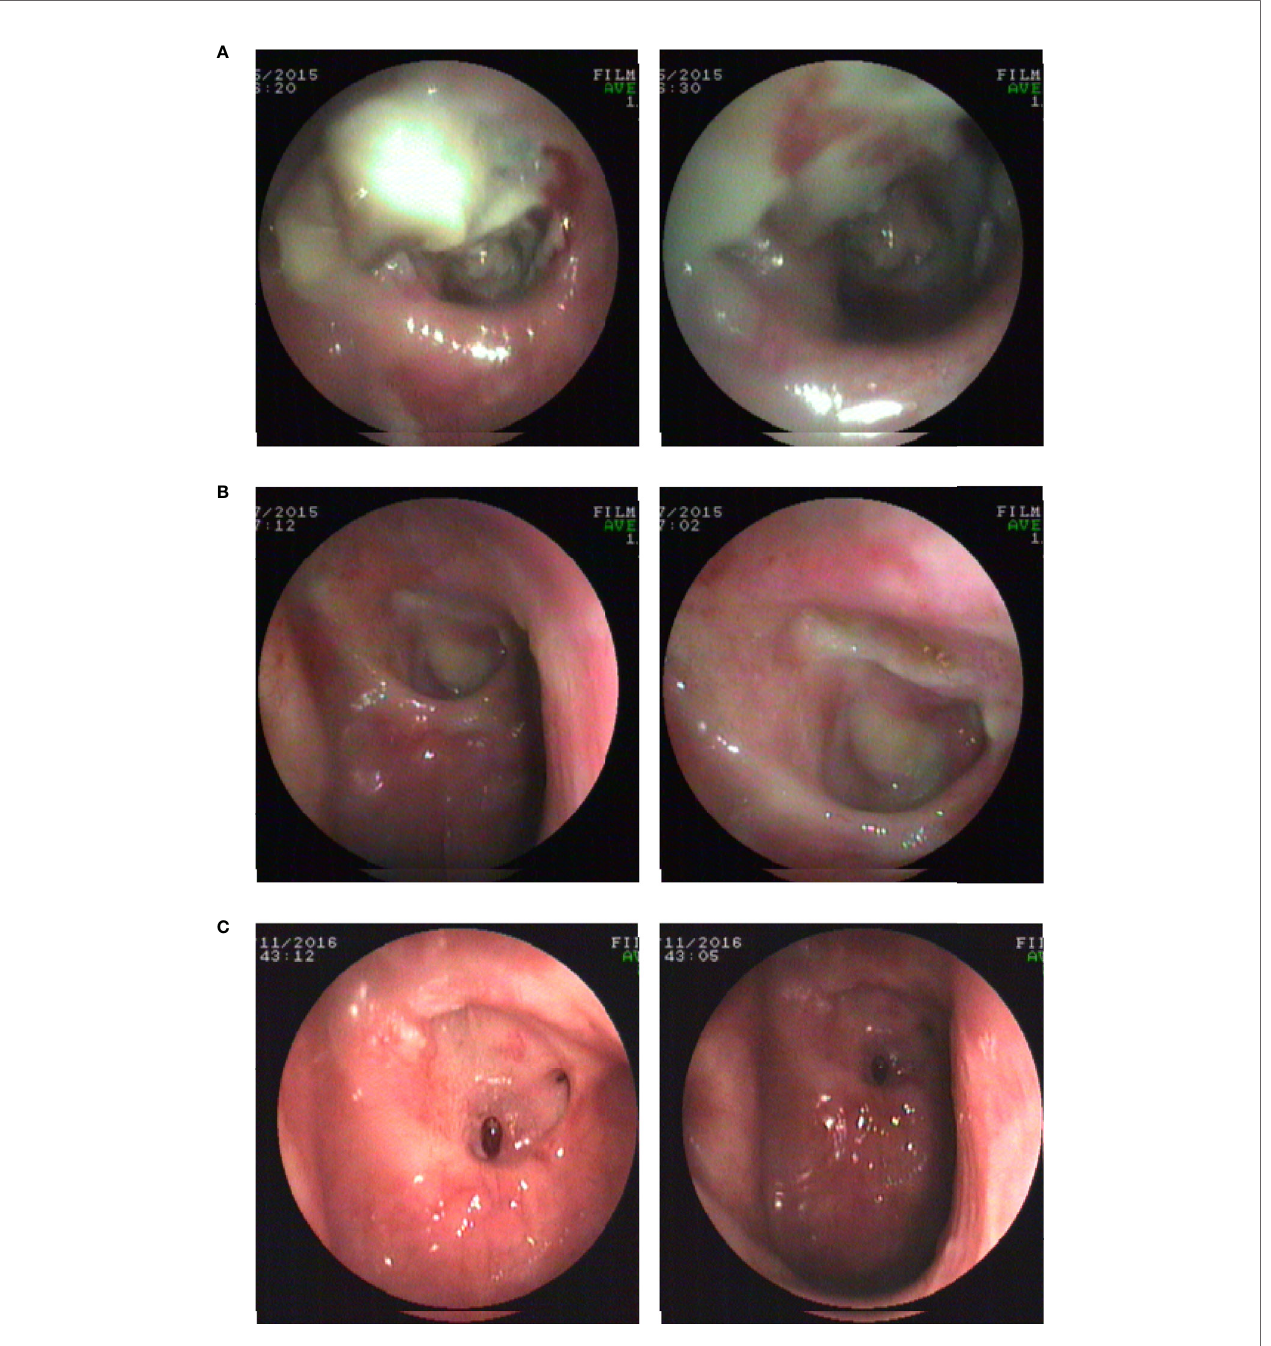
FIGURE 3 | Endoscopic images before and after modi fi ed irrigation. (A) Before modi fi ed irrigation, the necrosis is located in the nasopharyngeal cavity. (B) Three months after modi fi ed irrigation treatment, the necrotic secretions and tissues appear to have decreased. (C) One year after modi fi ed irrigation treatment, a small ulcer remains in the posterior wall of the nasopharynx, but necrotic secretions and tissues